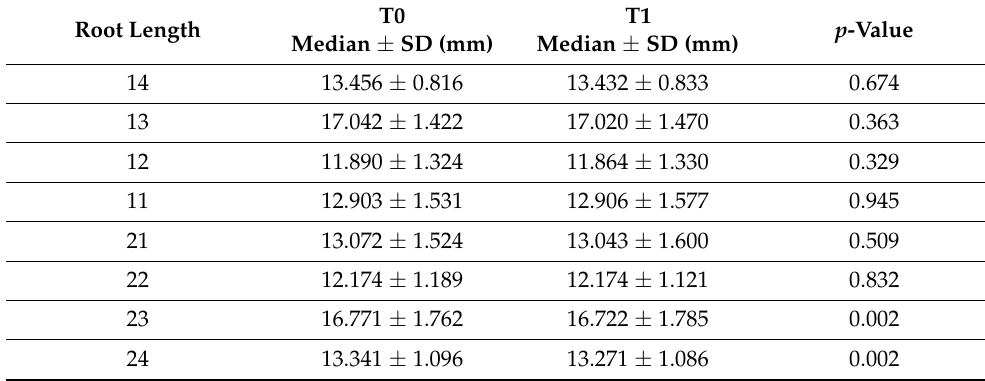
Table 7. Root length at T0 and T1 for maxillary teeth.